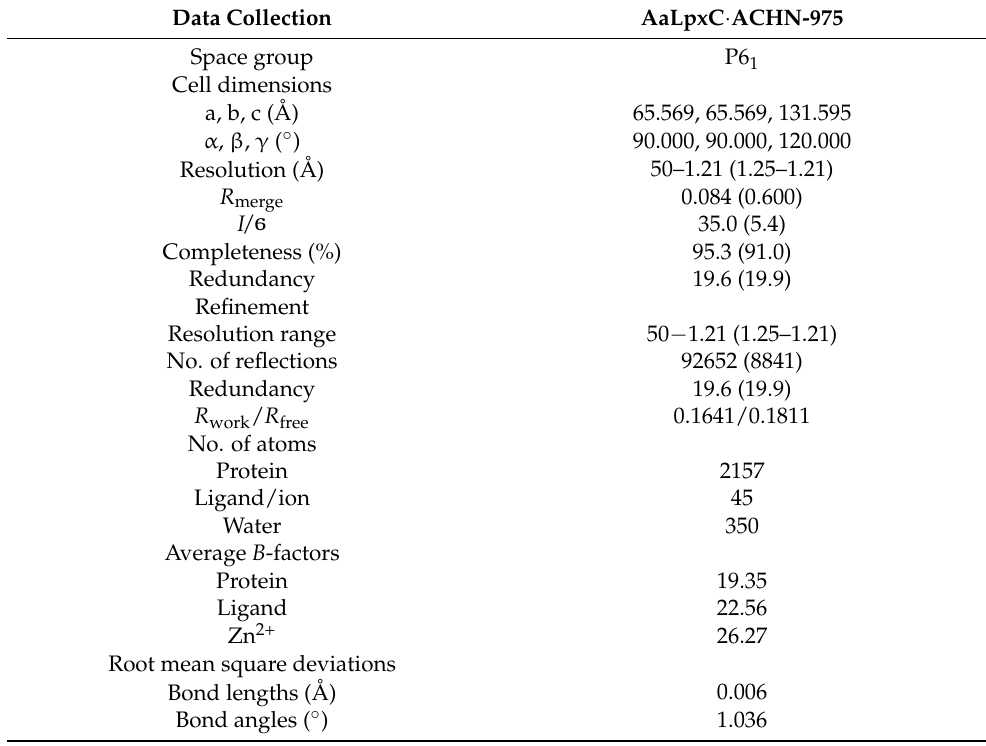
Table 1. X-Ray Data Collection and Structure Refinement Statistics.